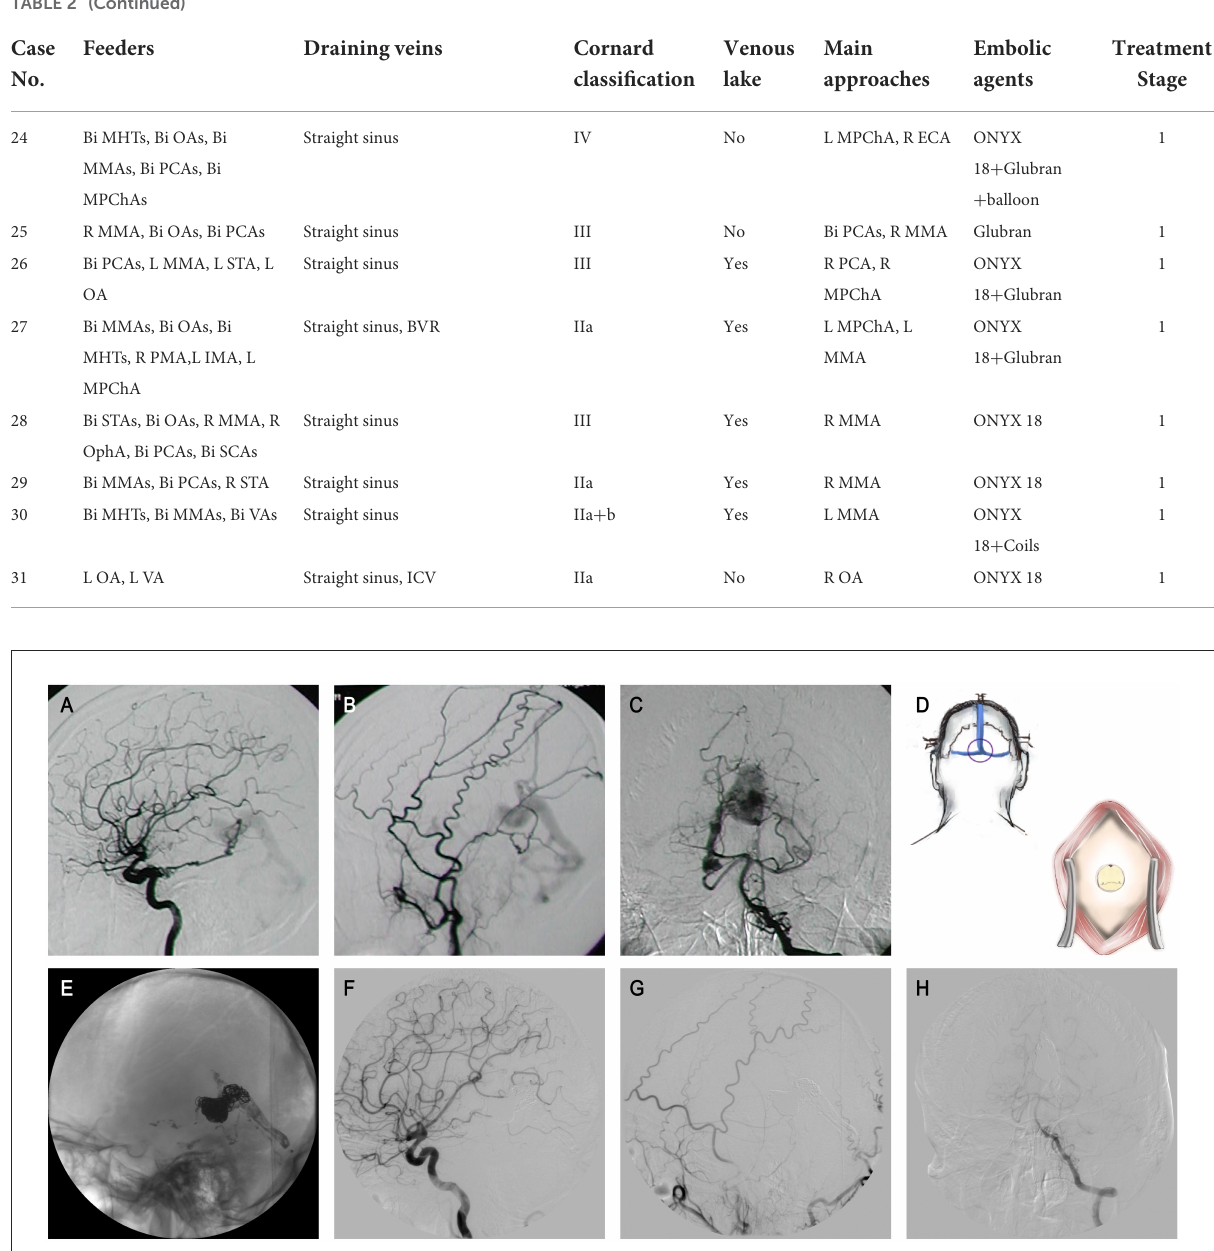
FIGURE1 The patient 9 presented with a history of conjunctival congestion for 5 years and proptosis of the right eye for 3 years. (A–C) Lateral ICA and ECA angiography, and anteroposterior VA angiography revealed GDAVF feeded by left IMA, bony branch and parietal occipital branch of bilateral MMA, bilateral PCA and OA, left PMA, and bilateral SCA. (D) Schematic diagram. A hole was drilled surgically at the external occipital protuberance to establish an appraoch. (E–H) DSA images obtained 6 months after treatment showed almost completely fistula